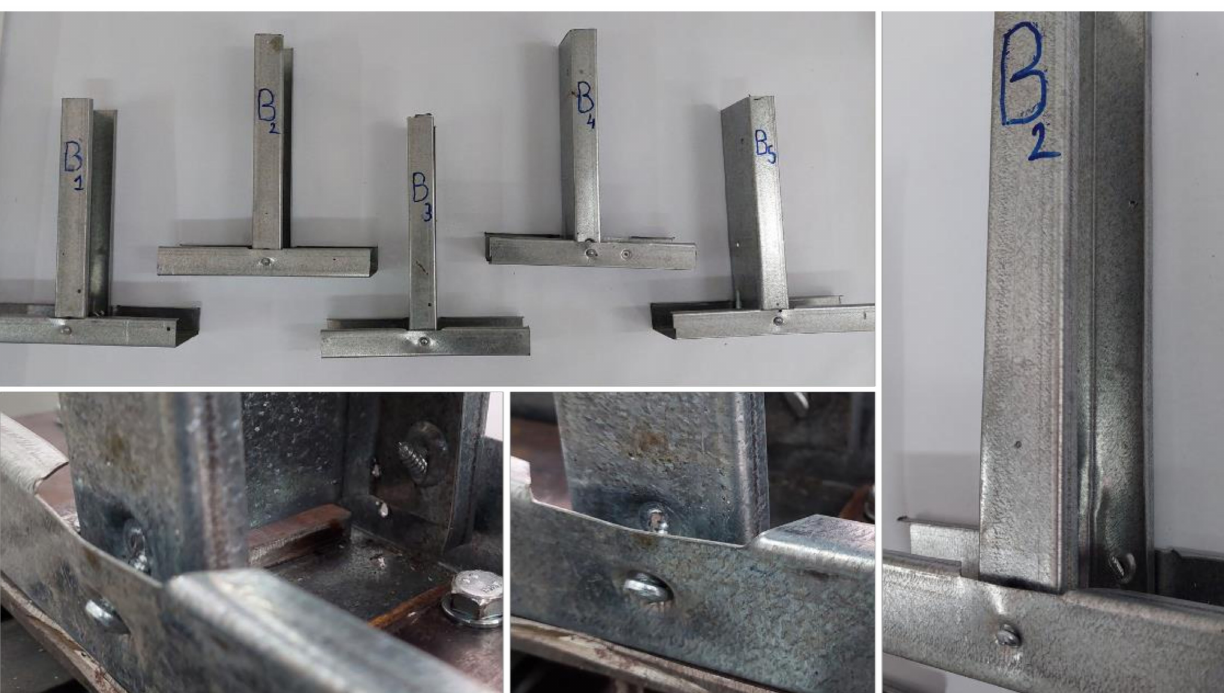
Figure 17. Joint B tested